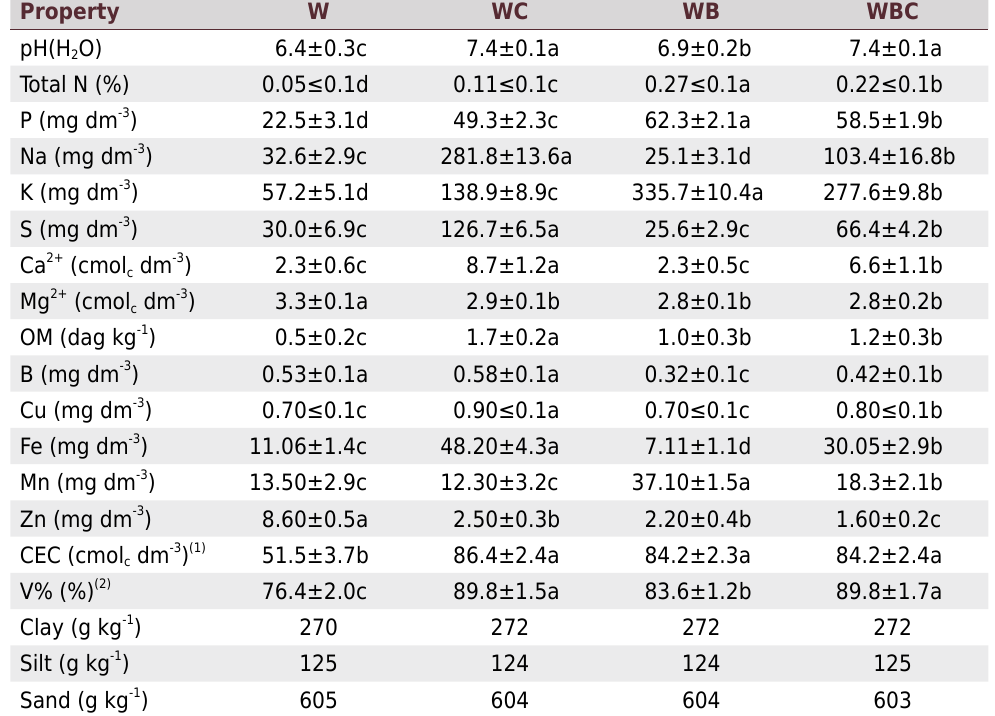
Table 2. Changes in soil properties in mining waste (W) by the addition of biochar (WB), compost (WC), and a combination of both (WBC)